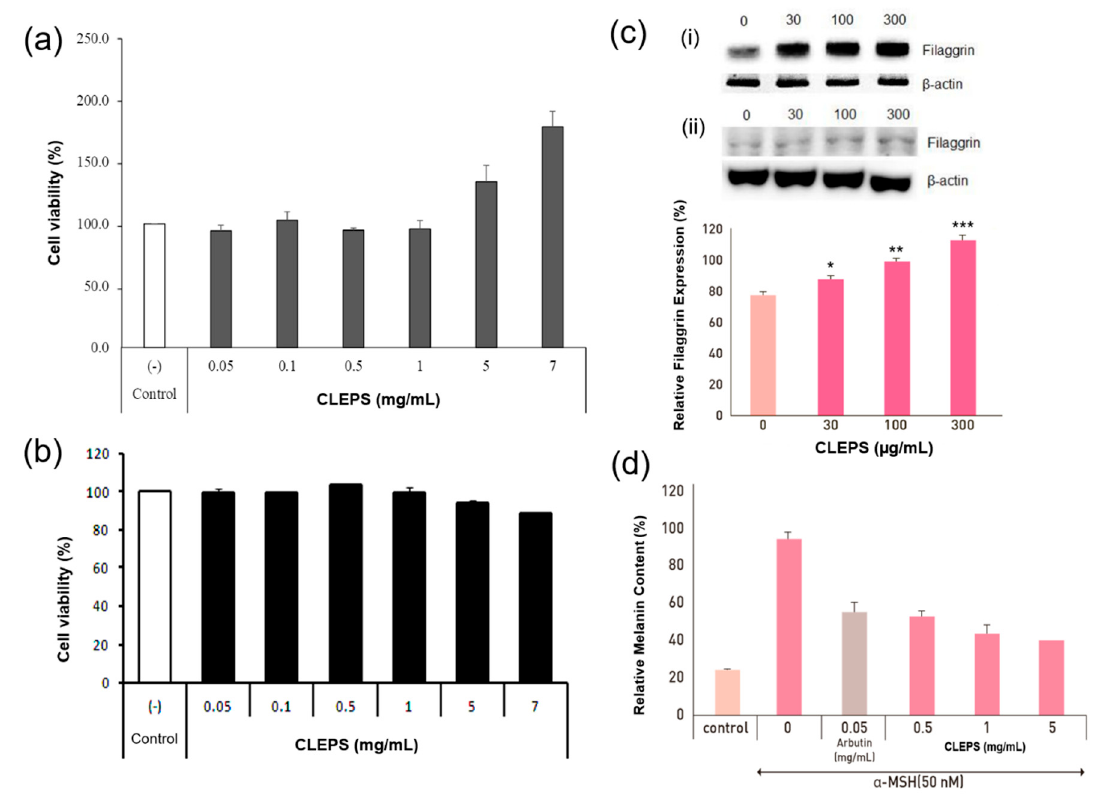
Figure 3. Cell viability and anti-inflammatory tests. Cell viability assays performed with a MTT assay on human dermal fibroblasts (NHDF) ( a ) and B16 melanoma cells ( b ). Effects of CLEPS on expression of filaggrin mRNA (i) and proteins (ii) in HaCaT cells ( c ) (* p < 0.05 ** p < 0.01 *** p < 0.001 vs. untreated). Melanin inhibition in B16 melanoma cells was evaluated by comparing the change in melanin content (%) according to the change in absorbance of the CLEPS untreated group with α -MSH ( d ) ( p > 0.05 vs. control).